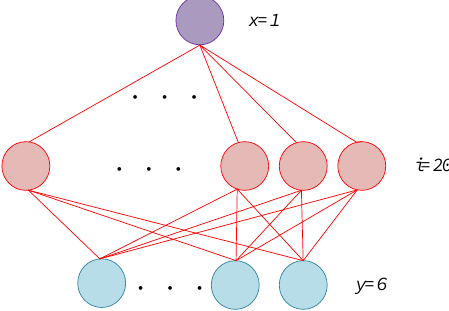
Figure 4. Structure of Fast Depth-Assisted Single-Shot MultiBox Detector.